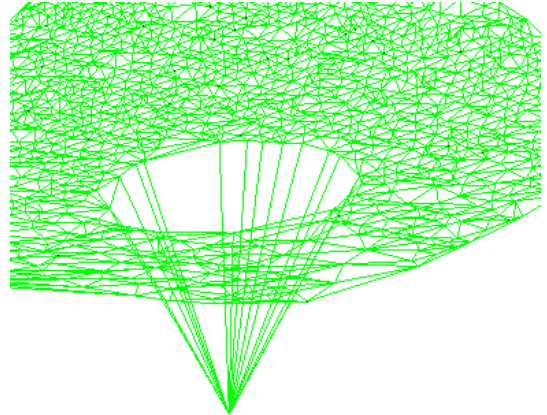
Figure 3. Erosion process caused by low